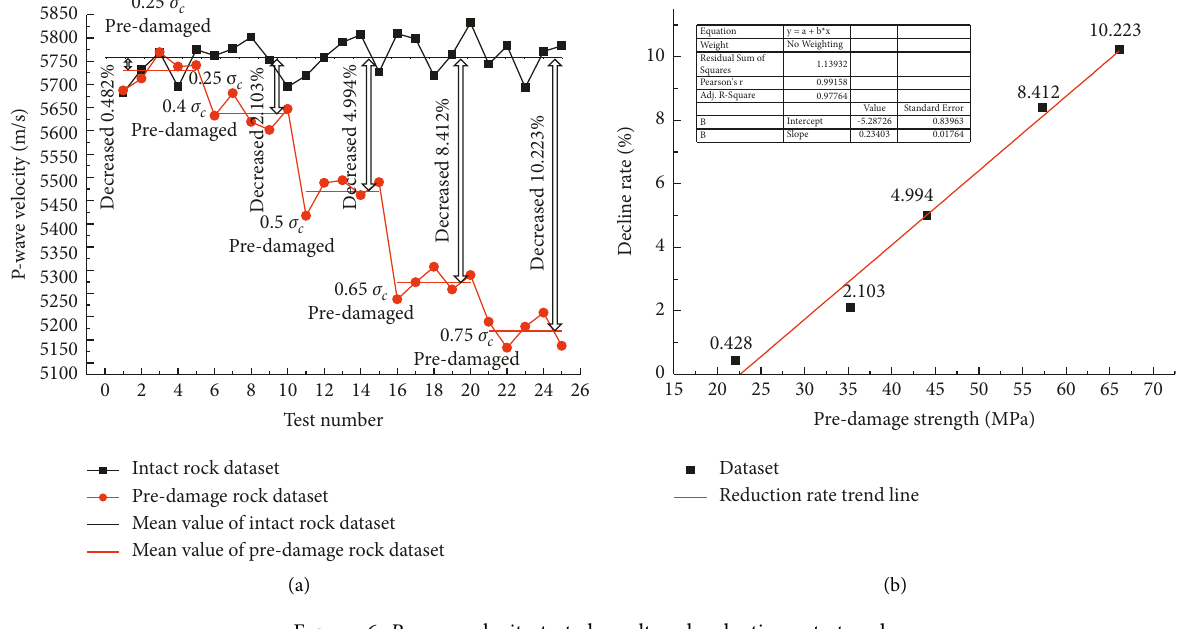
Figure 6: P -wave velocity tested result and reduction rate trend.